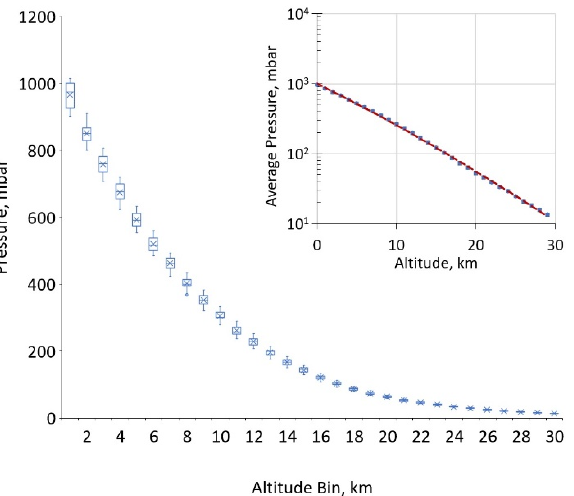
Figure 3. The extracted pressure profiles for the decade-long, 7-day window are sorted into 1 km bins to visualize pressure distributions at different altitudes. Note: the statistical spread for pressure is not discernible in the inset, logarithmic plot.